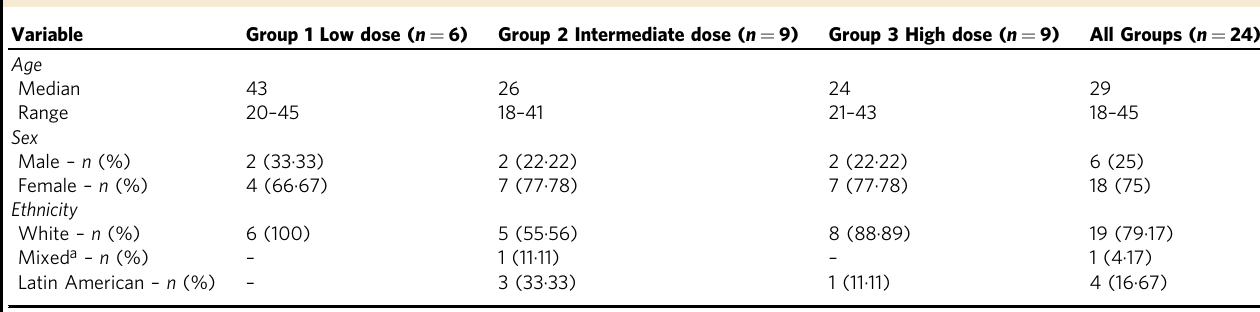
Table 1 Summary of participants ’ baseline